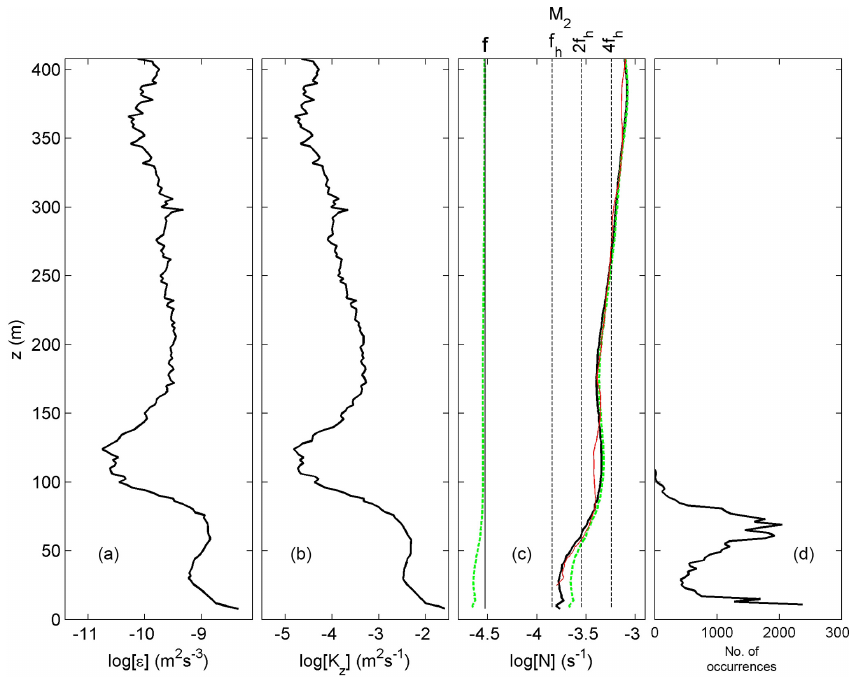
Figure 11. Profiles of turbulence parameters from entire-record time-averaged estimates using 1-day drift-corrected, 150s subsampled moored temperature data. (a) Logarithm of dissipation rate. (b) Logarithm of eddy diffusivity. (c) Logarithm of small-scale (2dbar) buoyancy frequency from the T sensors (black) for comparison with the mean of the five CTD profiles smoothed over 50dbar vertical intervals from Fig. 2a (red). The green dashed curves indicate the minimum (to the left of the f line) and maximum (to the right of the N profile) inertio- gravity wave bounds for meridional internal wave propagation (see text). (d) Probability density function (PDF) of the “bottom boundary layer height”, the level of the first passage of threshold N > 3 × 10 − 4 s − 1 , indicating the stratification capping the “near-homogeneous” layer from the bottom upward. Two peaks are visible, one near 10ma.b. attributable to bottom friction and another around 65ma.b. attributable to internal-wave-induced